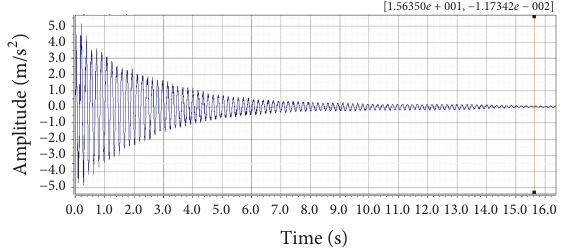
Figure 21: Response of the flexible arm with vibration absorber.